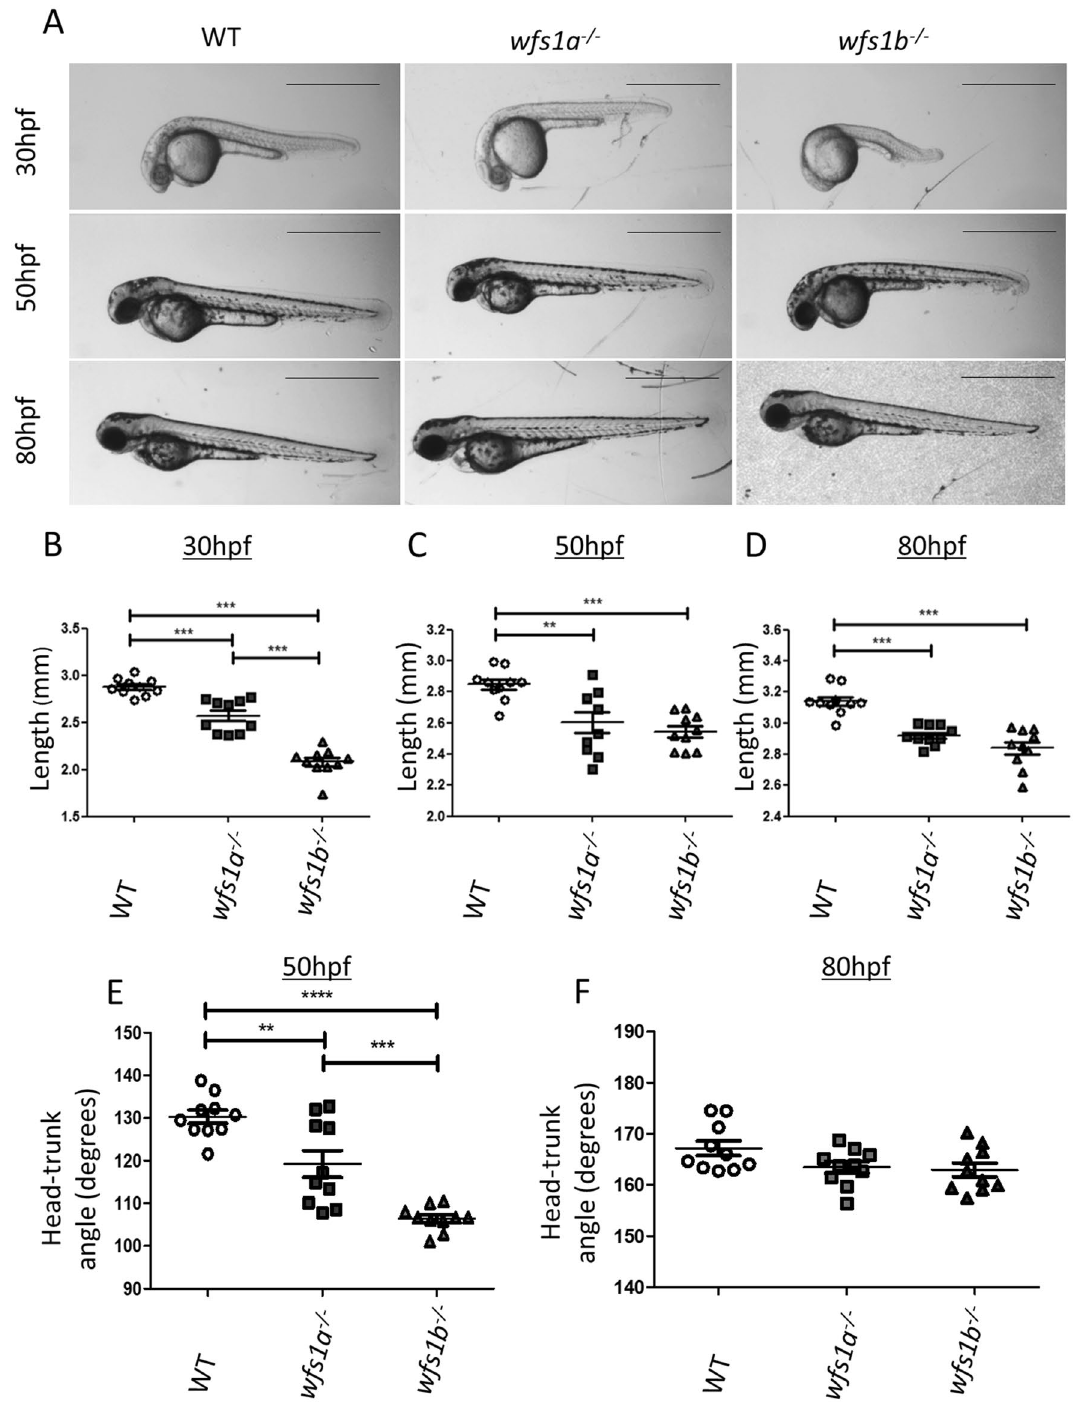
Figure 1. Phenotypic analysis of wfs1a −/− and wfs1b −/− zebrafish. ( A ) Zebrafish were imaged at 30, 50 and 80 hpf. Scale bars represent 1 mm. ( B–D ) Zebrafish length at 30 hpf ( B ), 50 hpf ( C ) and 80 hpf ( D ). ( E,F ) Zebrafish head-trunk angles at 50 hpf ( E ) and 80 hpf ( F ). Zebrafish length and head tail angle was measured using ImageJ and data plots represent mean ± SEM (n = 10). Statistical significance was determined by One-Way ANOVA with Bonferroni multiple comparisons. **p < 0.01; ***p < 0.001; hpf hours post-fertilisation, SEM standard error of the